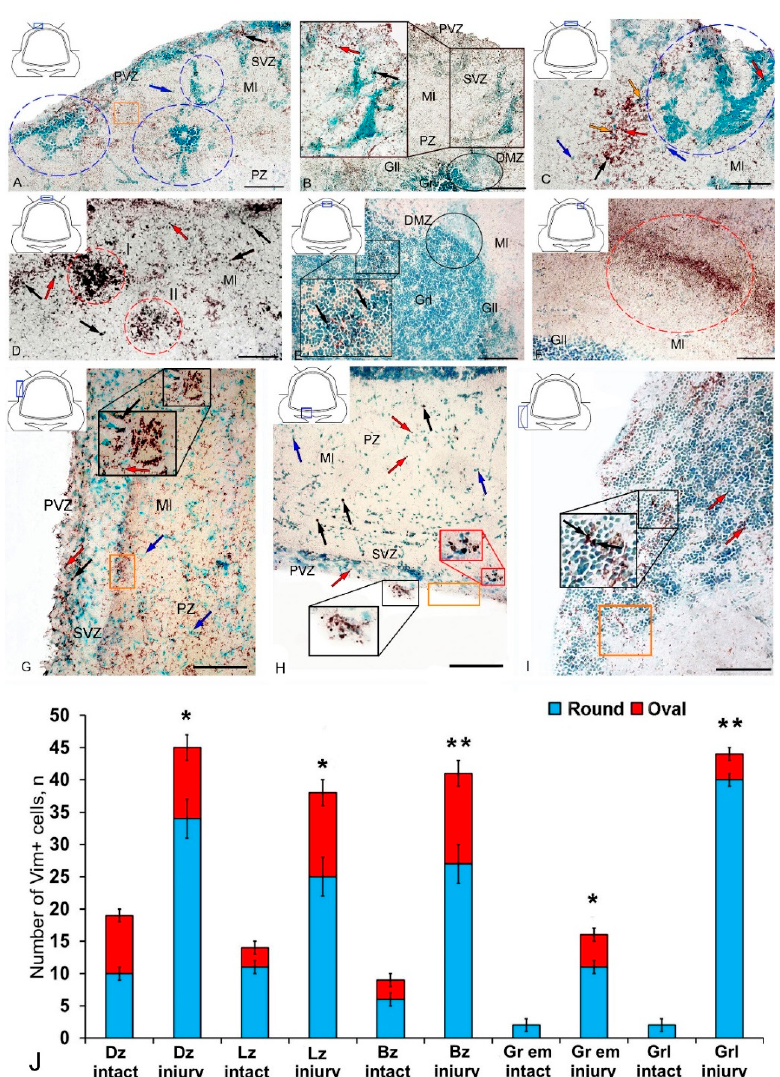
Figure 2. Distribution of vimentin in the cerebellum of juvenile masu salmon Oncorhynchus masou on day 2 post-injury. ( A ) Dorsal zone (DZ): Vim + cells (black arrows); Vim − cells (blue arrows); areas of extracellular deposition of vimentin are outlined by orange rectangle; reactive neurogenic niches are outlined by blue dashed ovals; periventricular zone (PVZ), subventricular zone (SVZ), parenchymal zone (PZ), molecular layer (Ml). ( B ) Enlarged fragment of DZ: Vim+ cells 1 type (red arrows), Vim+ cells 2 type (black arrows); a large aggregation of Vim − cells (black inset); dorsal matrix zone (DMZ) (black oval), granular layer (Grl), other designations see in Figure 2A. ( C ) Magnified fragment of DZ: Vim+ granules are outlined by orange rectangle, Vim+ granules (orange arrows). ( D ) Parenchymal part of the molecular layer of DZ, Vim+ cells 1 type (red arrows); clusters of Vim+ cells 2 type (black arrows) are outlined by red ovals (I and II). ( E ) Granular layer, Vim+ cells 1 type (red arrows); Vim+ cells 2 type (black arrows) and granules localized both inside cells and in the intercellular space (black inset); DMZ is outlined by black oval; ganglionic layer (Gll). ( F ) A focus of additional vimentin expression in the molecular layer of the DZ (in dashed oval). ( G ) Lateral zone: Vim+ cells 1 type (red arrows), Vim+ cells 2 type (black arrows). ( H ) Basal zone (see designations in Figure 2G). ( I ) Granular eminences see designations in Figure 2E. ( J ) Quantitative proportion of Vim+ cells in control and after traumatic injury. ( n = 5 in each group; * p ≤ 0.05 and ** p ≤ 0.01 is a significant difference vs. control groups). Student–Newman–Keuls test. IHC labeling of vimentin. The blue rectangle in the pictogram indicates the corresponding area in the micrograph. Scale bars: ( A , B , D – G ) 100 µ m; ( C ) 50 µ